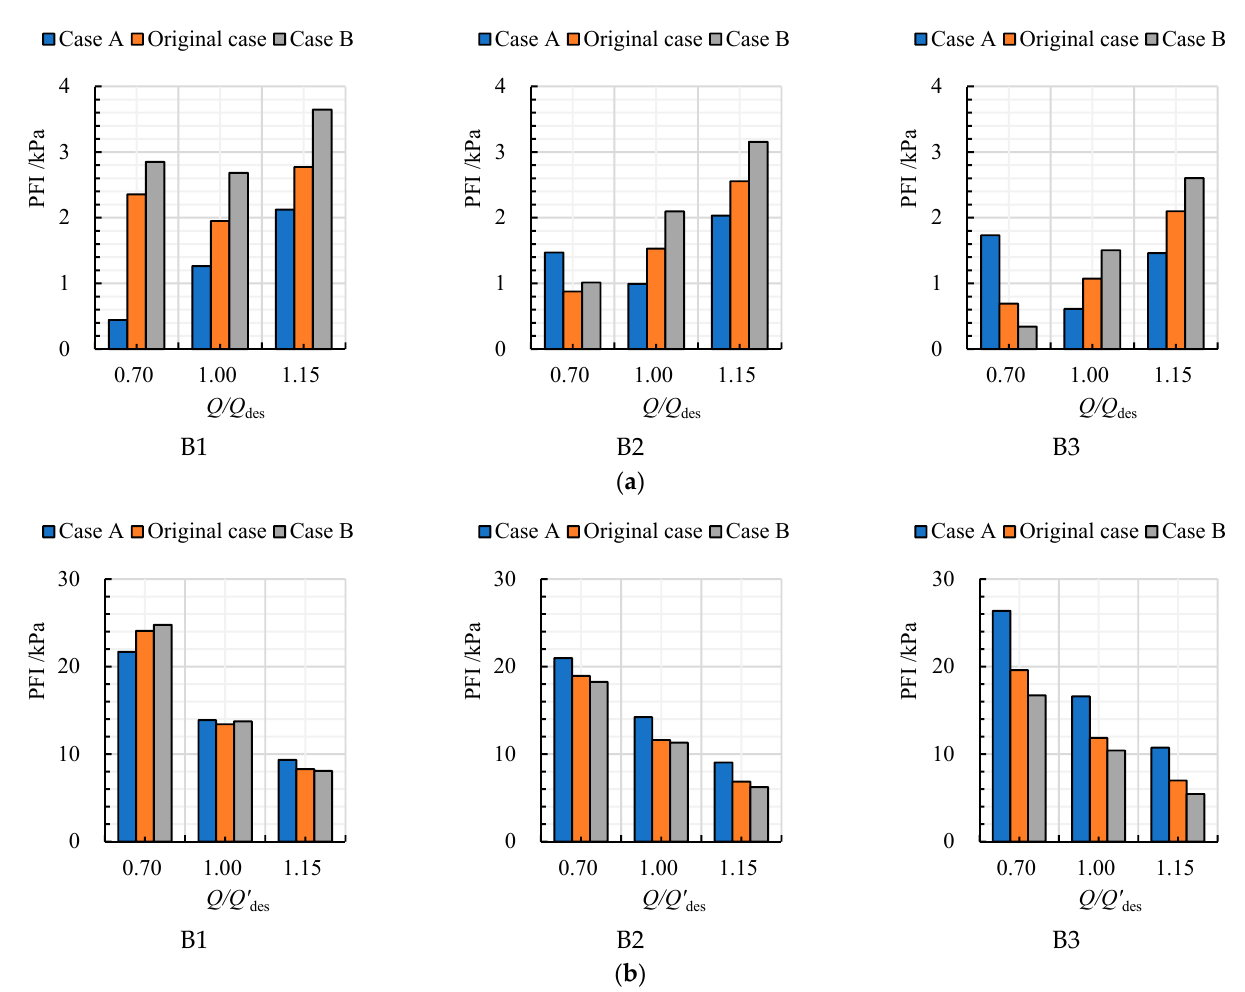
Figure 17. The distribution of PFI on B1, B2, B3 of three cases under ( a ) forward condition and ( b ) reverse condition.